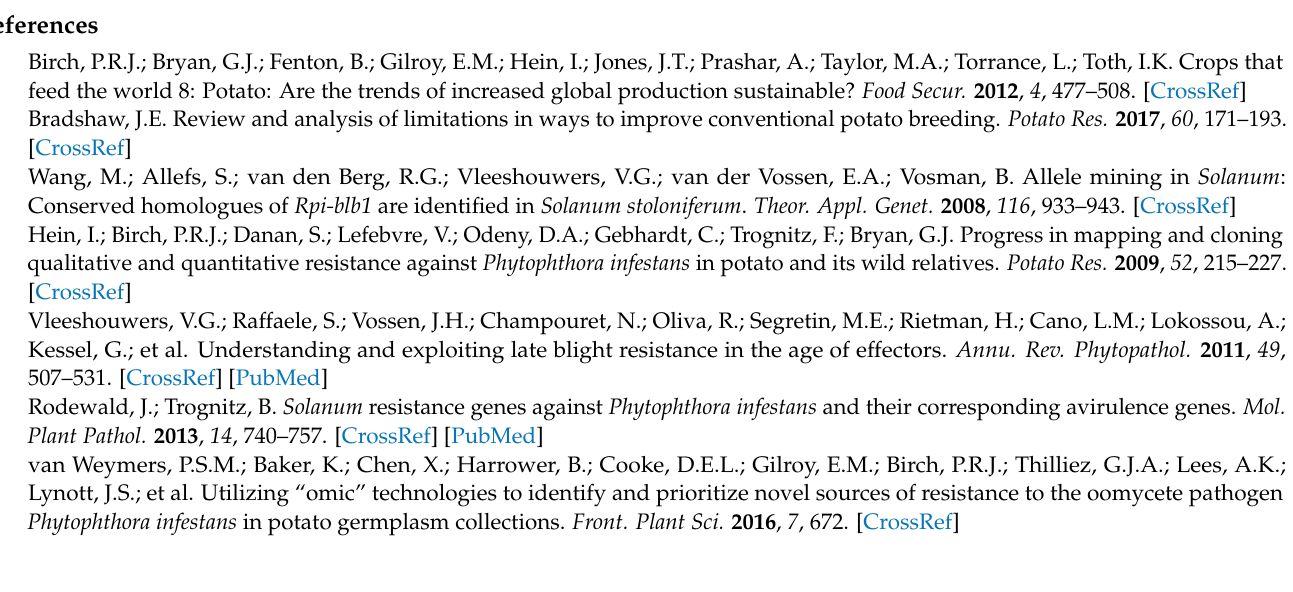
Table S1: Solanum species and accessions studied; Table S2: Screening S. bulbocastanum with SCAR markers of the Rpi genes and for late blight resistance; Table S3: Screening Solanum species Pinnati- secta series with SCAR markers of the Rpi genes and for late blight resistance; Table S4: Screening S. chacoesne ( Yungasensa series) with SCAR markers of the Rpi genes and for late blight resistance; Table S5: Screening Solanum species Tuberosa (wild species) series with SCAR markers of the Rpi genes and for late blight resistance; Table S6: Screening Solanum species Tuberosa (cultivated species) series with SCAR markers of the Rpi genes and for late blight resistance; Table S7: Screening Solanum maglia ( Maglia series) with SCAR markers of the Rpi genes and for late blight resistance; Table S8: Screening S. demissum ( Demissa series) with SCAR markers of the Rpi genes and for late blight resistance; Table S9: Screening Solanum species Longipedicellata series with SCAR markers of the Rpi genes and for late blight